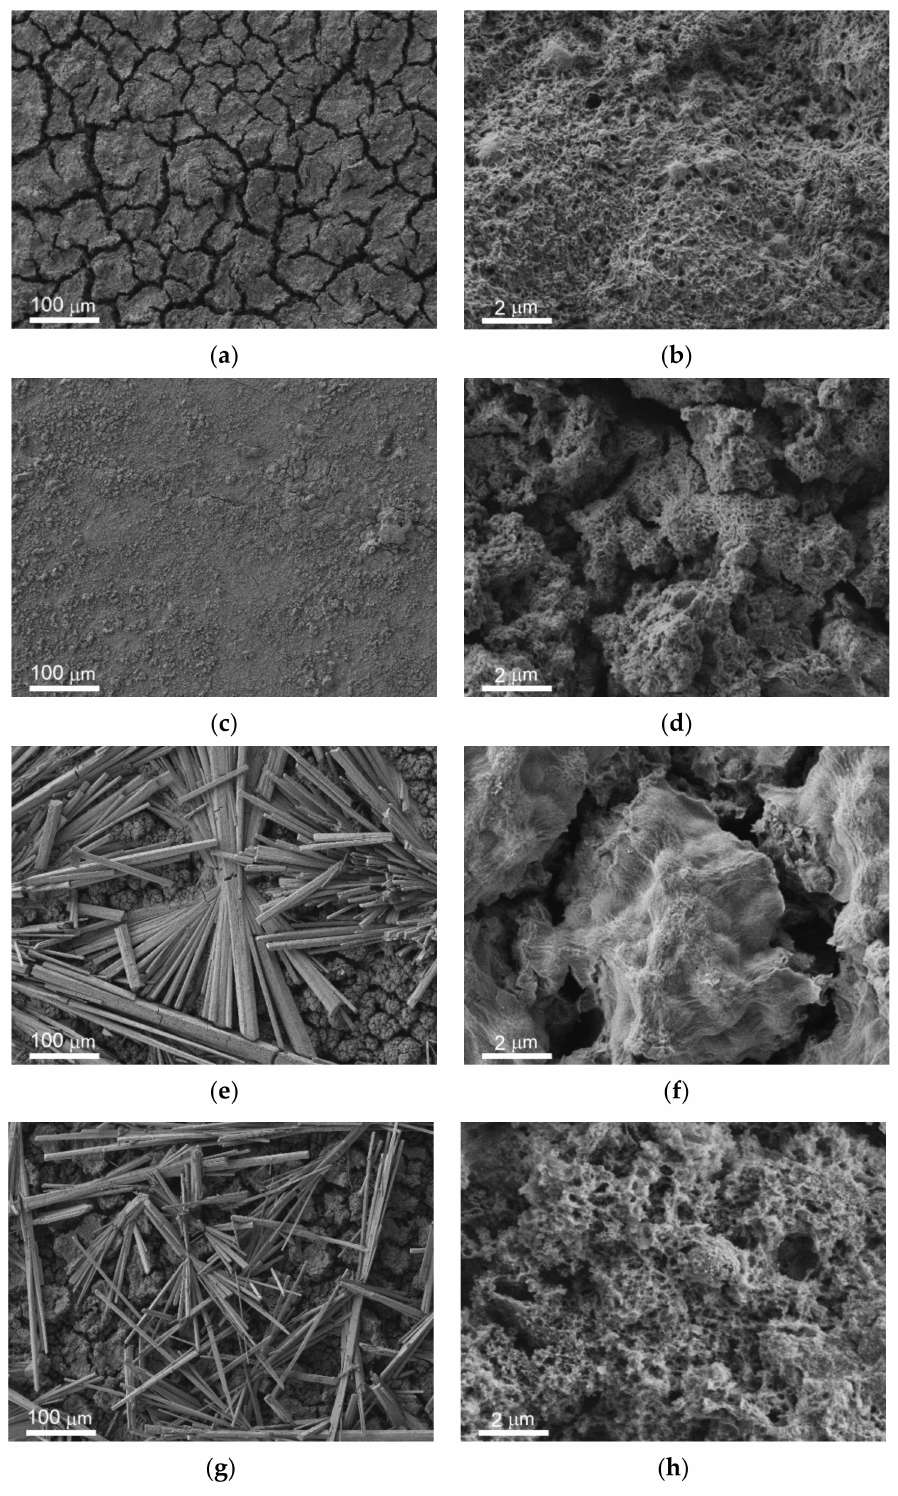
Figure 2. SEM images with different magnifications illustrating the morphology of magnesium alloy samples with different wettabilities before ( a , b ) and after ( c – h ) immersion for 48 h into a phosphate buffer solution (PBS): ( a , b ) laser-textured superhydrophilic or superhydrophobic samples; ( c , d ) polished bare MA8 sample; ( e , f ) superhydrophilic sample; ( g , h ) superhydrophobic sample. The images are arranged as follows: left column ( a , c , e , g ) presents survey images with a scale bar of 100 µ m; right column images ( b , d , f , h ) show the details of the surface structure at a larger magnification with a scale bar of 2 µ